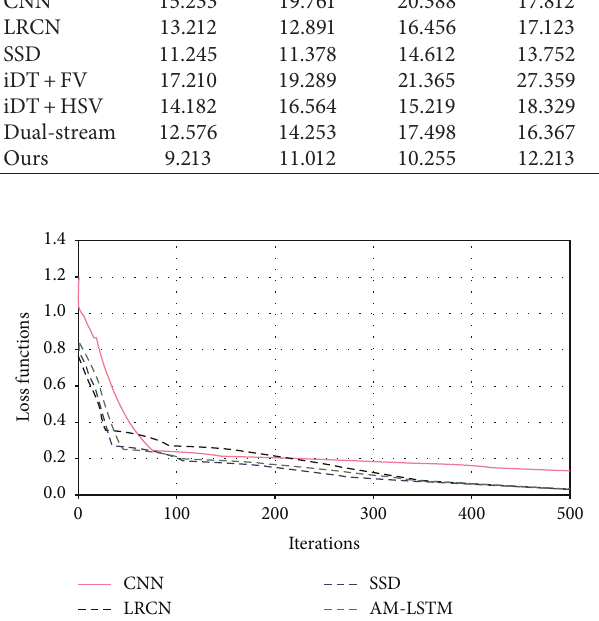
Figure 13: Loss function curves of the four models training.